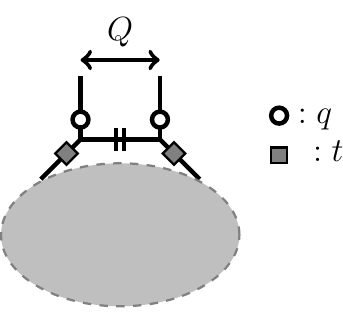
Figure 28 . A 5-brane web which contains extra factor from the topological vertex calculation. By assigning re(cid:12)ned topological vertex (B.3) for each vertex and also the weights (B.6) or (B.8), the topological string partition function is given by summing all the assigned Young diagrams. The rules for the unre(cid:12)ned version can be obtained simply by setting t = q